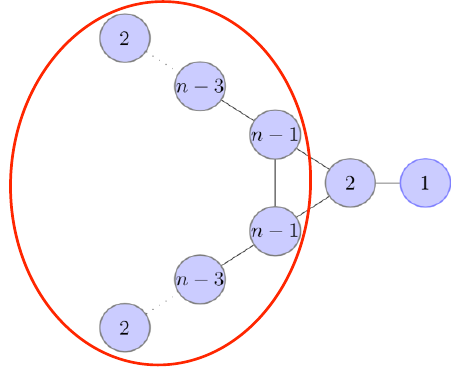
Figure 12 . The 3D mirror of the S 1 reduction of the R 2 ; AD theory. Nodes and lines are de(cid:12)ned 0 ;n as in (cid:12)gure 11. The two quiver tails corresponding to the TQFT wave functions with conjugate fugacities are fused together to give one linear set of nodes generating an SU( n ) symmetry. The corresponding nodes are inside the red oval. The remaining quiver tail gives an SU(2) symmetry and is symmetrically fused with the SU( n ) nodes via an unbalanced SU(2) node. As a result, the quiver contains a closed non-abelian loop, and the theory can (cid:13)ow to an interacting N = 8 SCFT via the procedure described in the